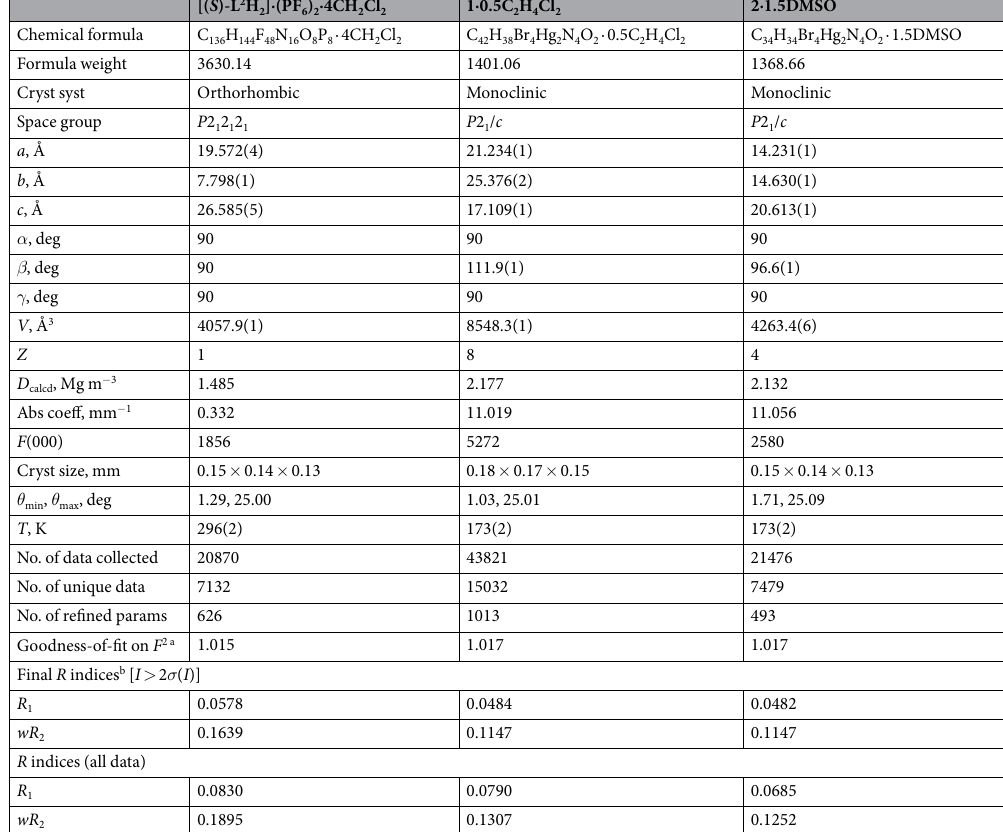
Table 1. Summary of crystallographic data [( S ) -L 2 H 2 ] · ( PF 6 ) 2 , 1 and 2 . a GOF = [ Σ w(F o2 − F c2 ) 2 /( n − p )] 1/2 , where n is the number of reflection and p is the number of parameters refined. b R 1 = Σ ( ||F o | − |F c || )/ Σ |F o | ;